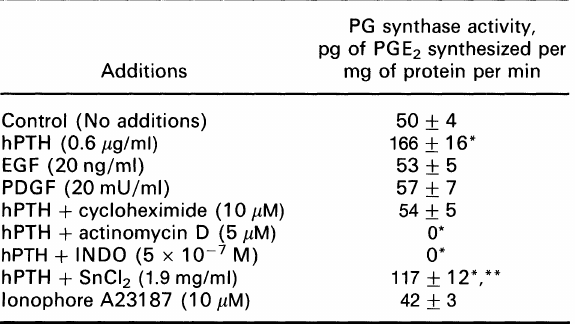
Table 1. The effect of hPTH-(1-34) and other additives on PG synthase activities in chick calvariae